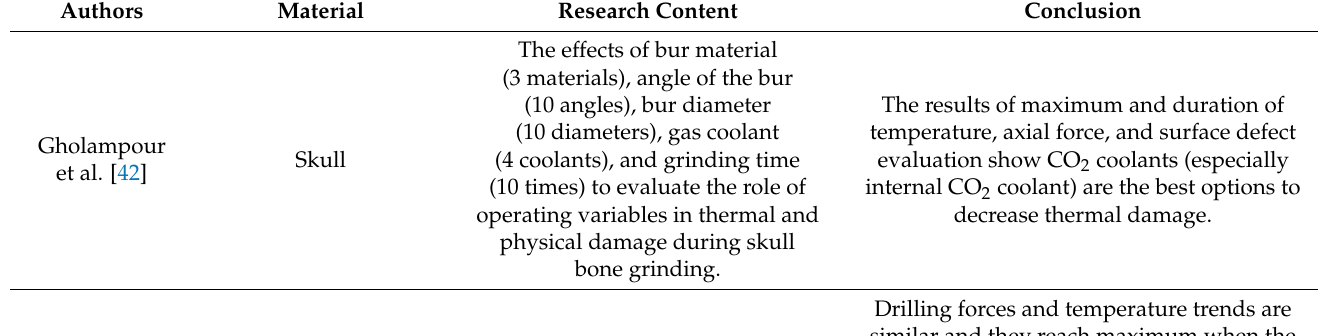
Table 9. Comparison between previous mostly related studies and this